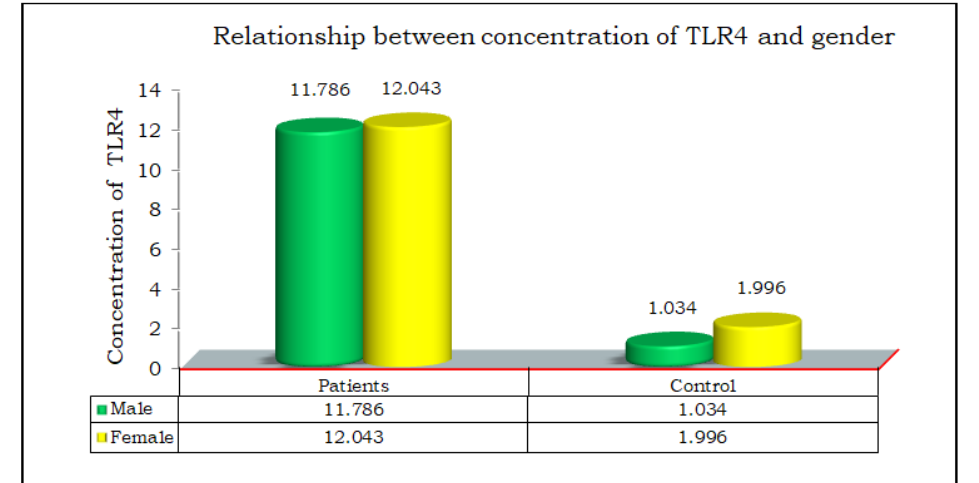
In the current study, it was also observed that the mean for the concentration of TLR4 in male patients' groups was 11.786, and in the control groups it was 1.034, which is higher than the mean for the concentration of TLR4 in the female patients' groups, as it was 12.043 and in the control groups it was 1.996. The means and the standard deviations were calculated at a significant level p ˂ 0.05